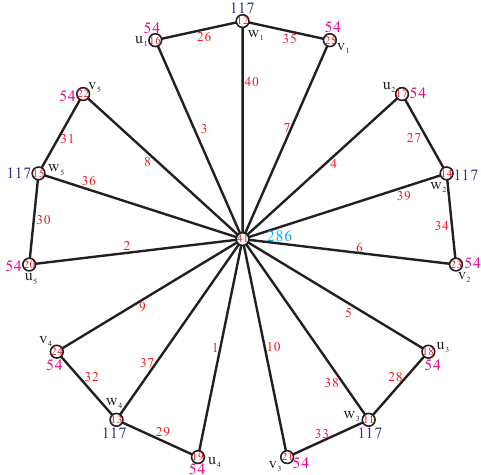
Figure 13. The local antimagic total labeling of AD 5